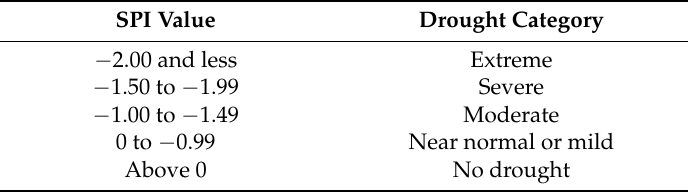
Table 3. SPI values that show different categories of drought severity (McKee et al.